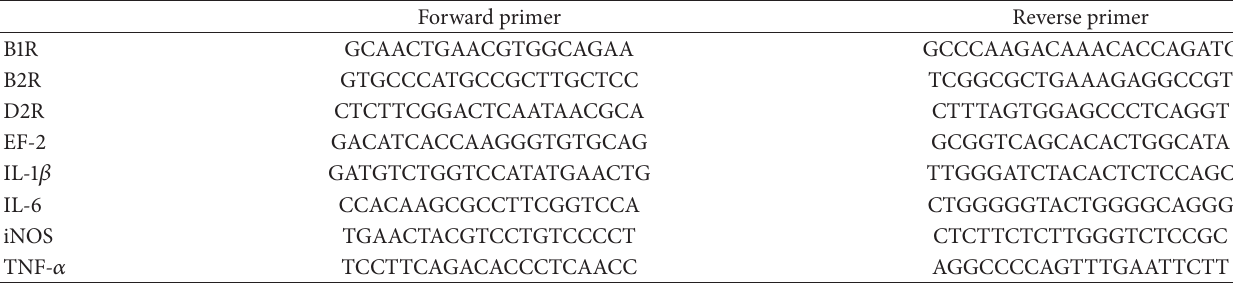
Table 1: Sequences of primers used for Real-Time PCR